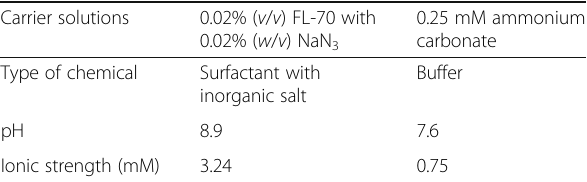
Table 4 Properties of carrier solutions Carrier